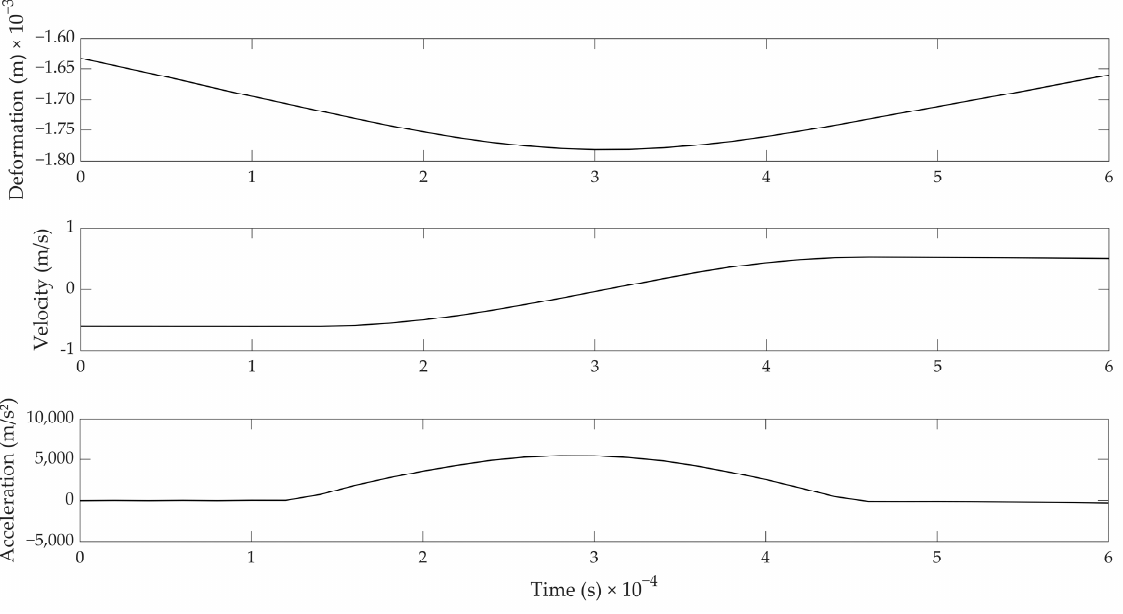
Figure 3. Zoomed view of the first impact on the egg with the steel ball. ( Top ): Deformation (m); ( middle ): velocity (m/s); and ( bottom ): acceleration (m/s²).